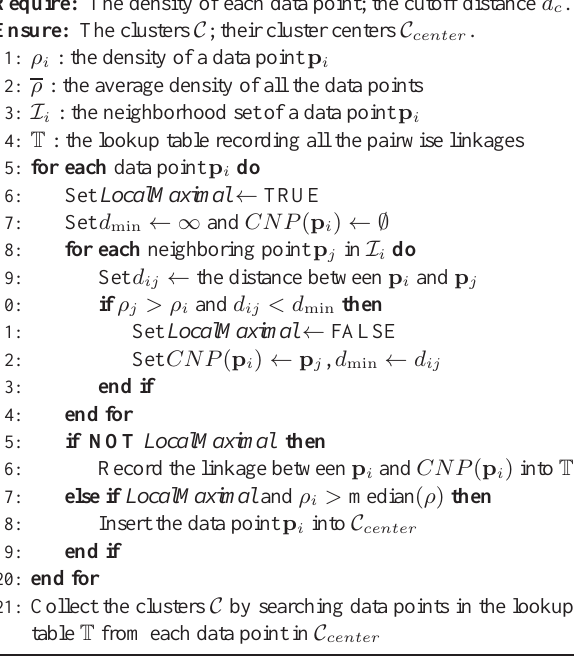
Algorithm 1 Hierarchical Clustering by Pairwise Linkage